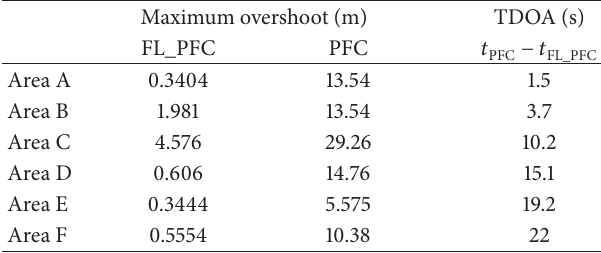
Table 2: Comparison of the maximum overshoot with the two proposed